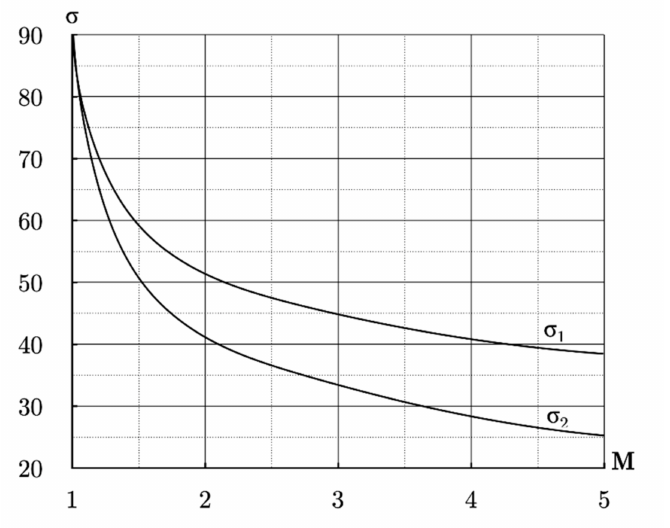
Figure 8. Optimal angles of inclination of overtaking shocks, ensuring minimum total pressure loss, γ = 1.4.